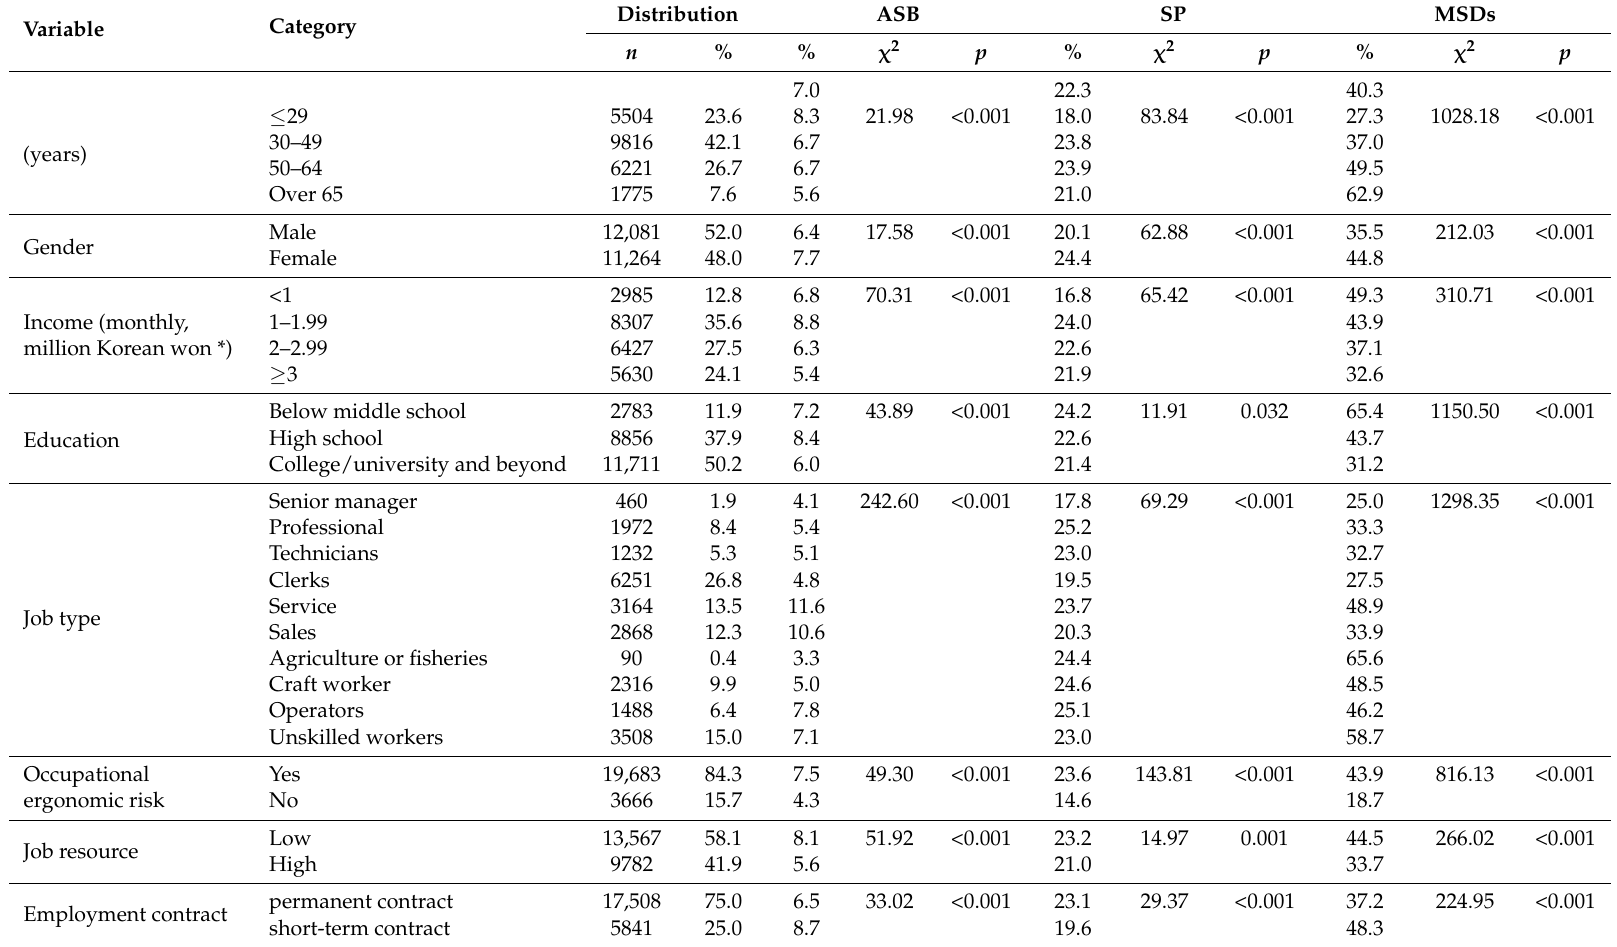
Table 1. Distribution of study population and prevalence of ASB, SP, and MSDs by key covariates ( N =